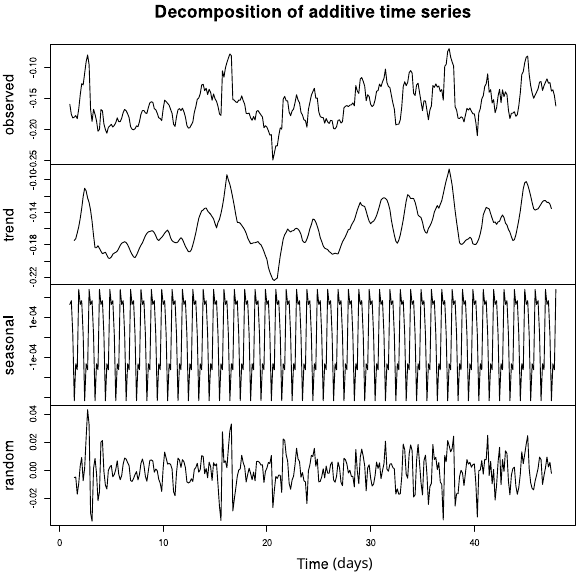
Figure A1. Year–Long time series of daily averaged compounded sentiment polarity of COVID-19-related tweets, utilizing VADER in Mexico . Shown is the decomposed sentiment analysis: the averaged time series, trends, weekly seasonality, and random data. The time axis is shown in days, starting